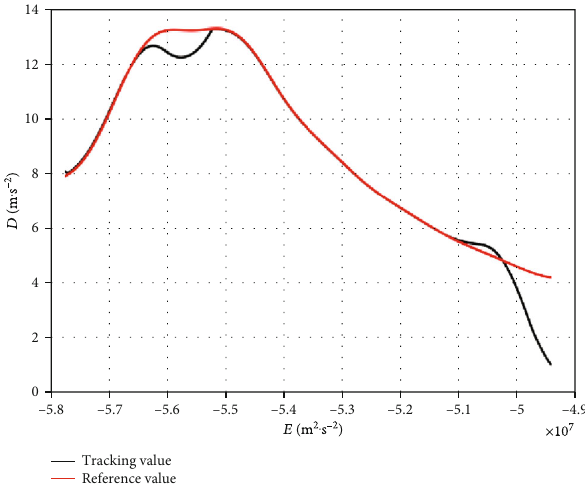
Figure 15: Maximum drag acceleration pro fi le tracking ability. Table 2: Computation times of di ff erent methods.